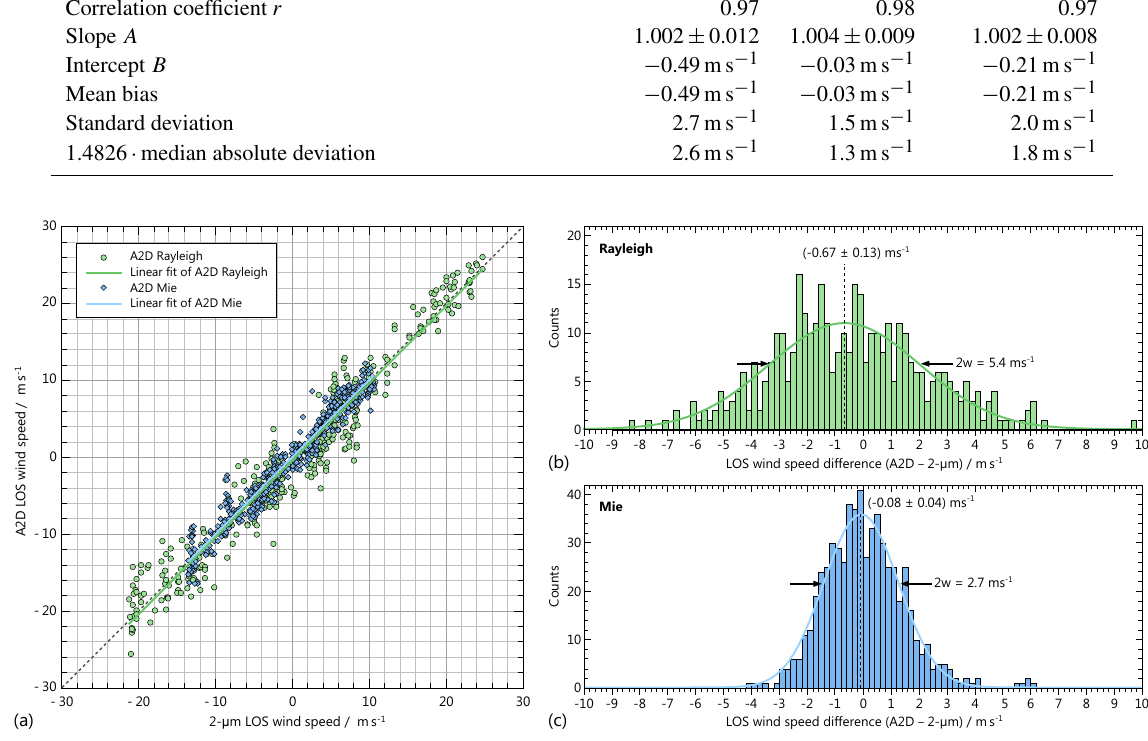
Figure 9. (a) A2D LOS wind speed determined with the Rayleigh (dots) and Mie (diamonds) channel versus the 2µm LOS wind speed for comparison of the wind data measured during the flight on 27 September 2016 between 10:28 and 12:36UTC (see corresponding curtains in Fig. 7a, b and d). The scatterplot is obtained by adaptation of the different measurement grids of the two systems based on a weighted interpolation algorithm and a subsequent bin-to-bin comparison. The corresponding probability density functions for the wind differences (A2D–2µm) are shown in panels (b) and (c) for the Rayleigh and Mie channel, respectively. The solid lines represent Gaussian fits with the given centres and e − 1 / 2 widths 2 w